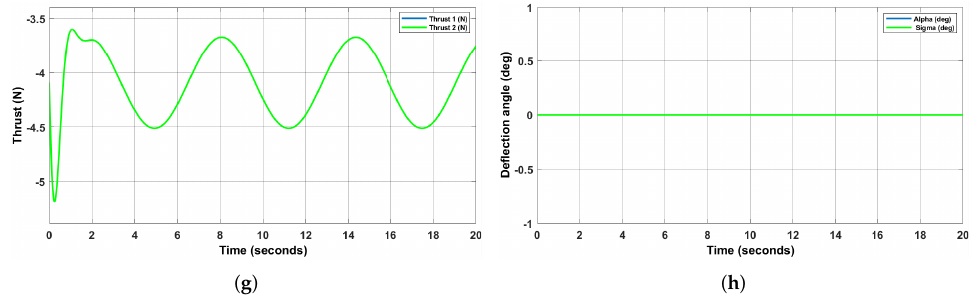
Figure 20. Responses for first simulation: ( a ) X response; ( b ) φ response; ( c ) Y response; ( d ) θ response; ( e ) Z response; ( f ) ψ response; ( g ) thrust response; ( h ) deflection angles